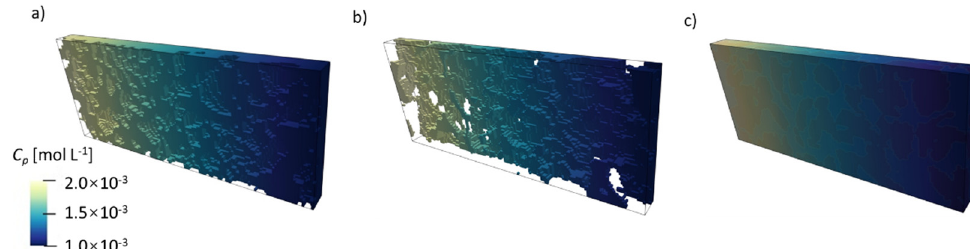
Figure 6. 3D view of the simulated tracer concentrations across the sampled porous media in ( a ) initial state (unreacted porous medium), ( b ) final state assuming no diffusion through the precipitates ( D s = 0), and ( c ) final state with diffusion through the precipitates with D s / D 0 = 0.01.